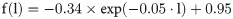
Neural responses to corner-folds vs. those to edge.(A) Root-Mean-Square (RMS) contrast along Edge. The light cyan dots show the numerically computed values of RMS contrast at various luminance levels along Edge. The dark cyan line is the exponential fit for Edge RMS contrast: fl=-0.34×exp-0.05∙l+0.95, where l is the luminance in percentage and fl is the RMS contrast. This model was used to calculate neural responses along Edge at equal RMS contrast intervals. (B) Neural responses along Edge. The orange dots indicate the neural responses along the Edge at equal luminance intervals of 10% (red shadows indicate the SEM), while the green dots indicate the neural responses at equal RMS contrast intervals of 0.037. (C) Neural responses to corner-folds and Edge. The red crosses represent the average neural response (spike rate difference) to the four corner-fold angles (at fold midpoints). The green dots are the neural response to Edge at equal contrast intervals, as described in (B). (D) Neural responses as a function of fold angle (red crosses) compared to DOG output (black line) obtained with similar stimuli [3]. Error bars indicate the SEM (the N are as in Fig 5).